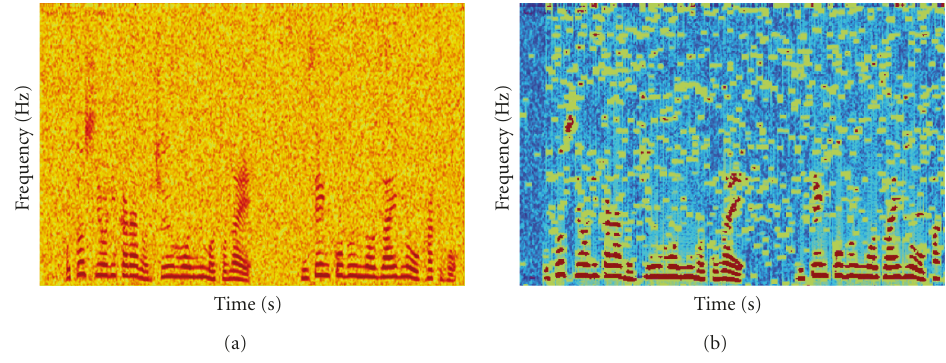
Figure 4: (a) Observed spectrogram and (b) processed